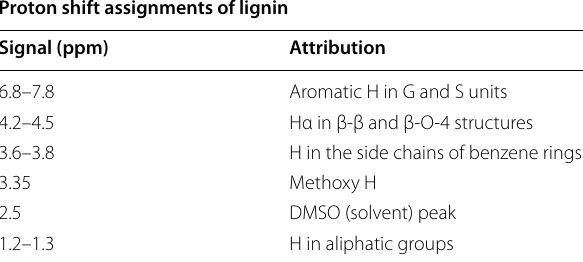
Table 7 Major 1 H-NMR signals of lignin and the corresponding assignments